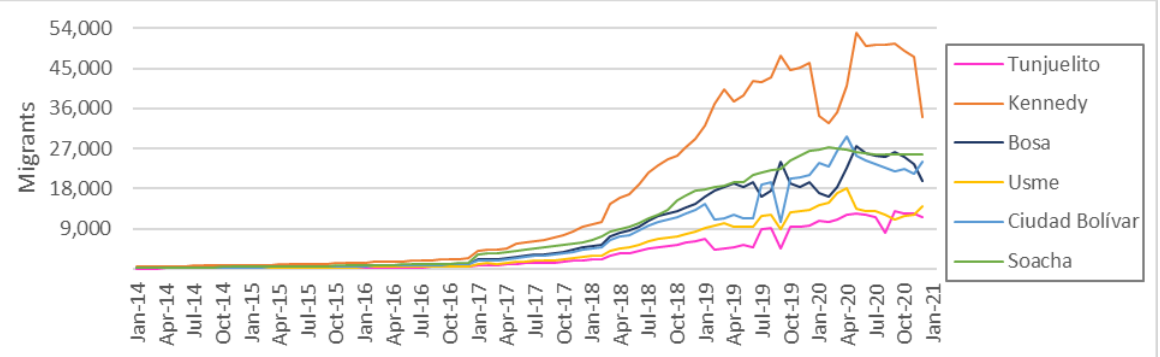
Figure 7. Historical estimate for number of migrants obtained by the mathematical approach for the localities being studied.